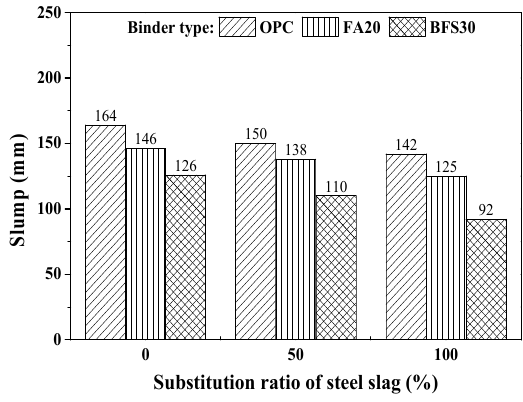
Figure 3. Results of slump test.